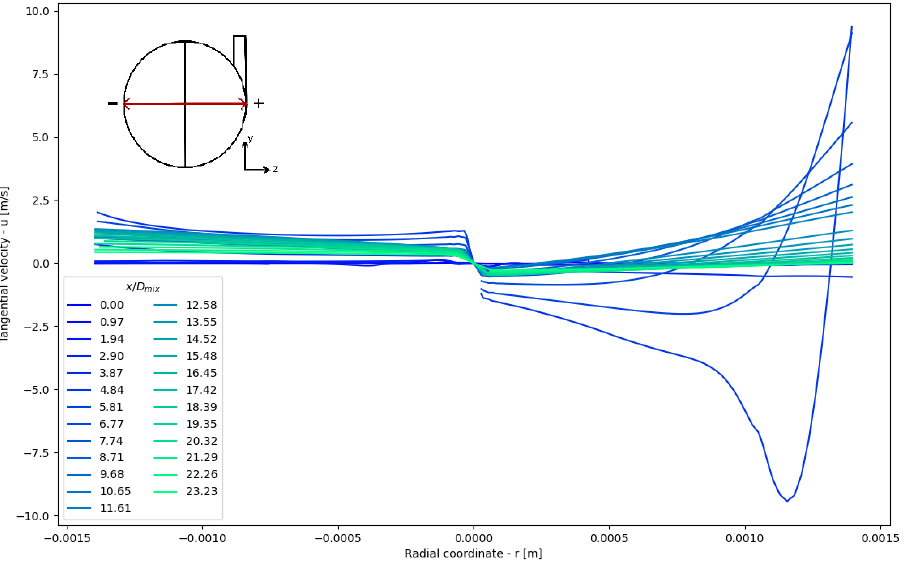
Figure 17. Tangential velocity plot in the z direction. Positive r direction is in the direction towards the bypass inlet, θ bp = 0 ◦